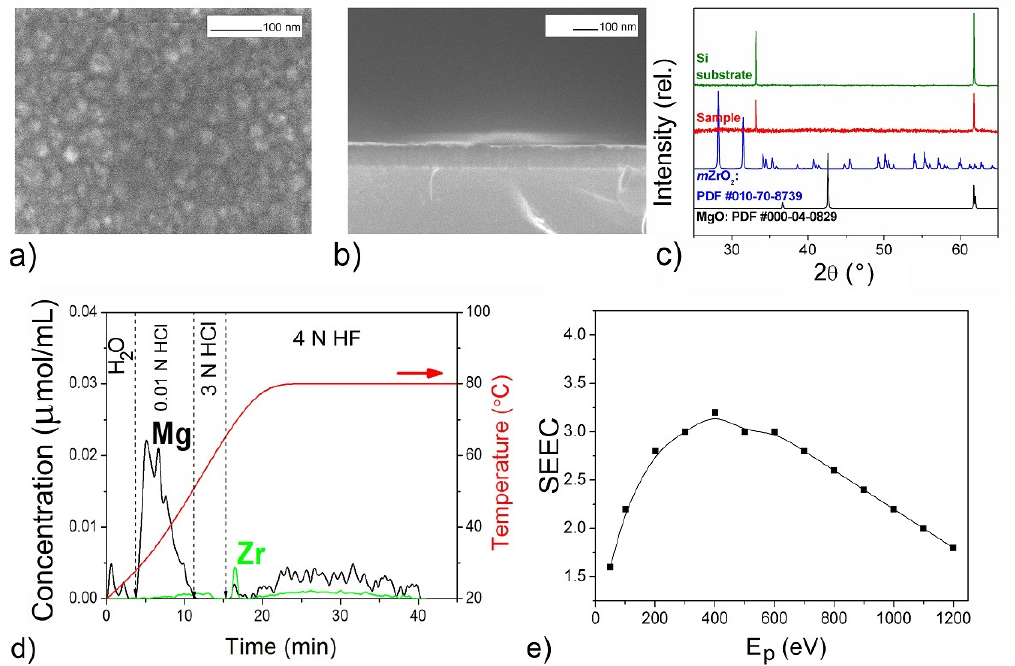
Figure 4. The mixed oxide film with n(Mg):n(Zr) = 11:9 according to DD data: SEM images ( a , b ), XRD pattern ( c ), DD curves ( d ), SEEC (Ep) curves ( e ).